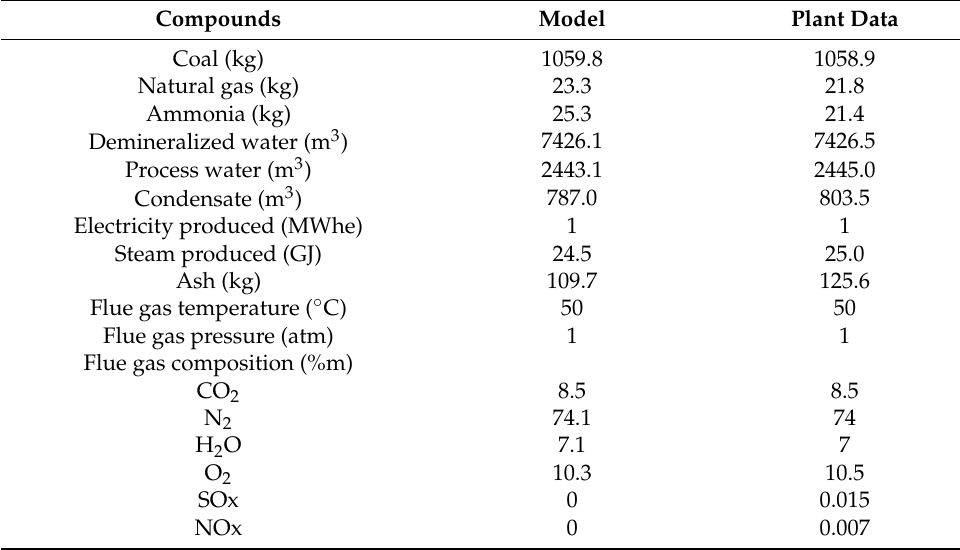
Table 1. Results of simulations for 1